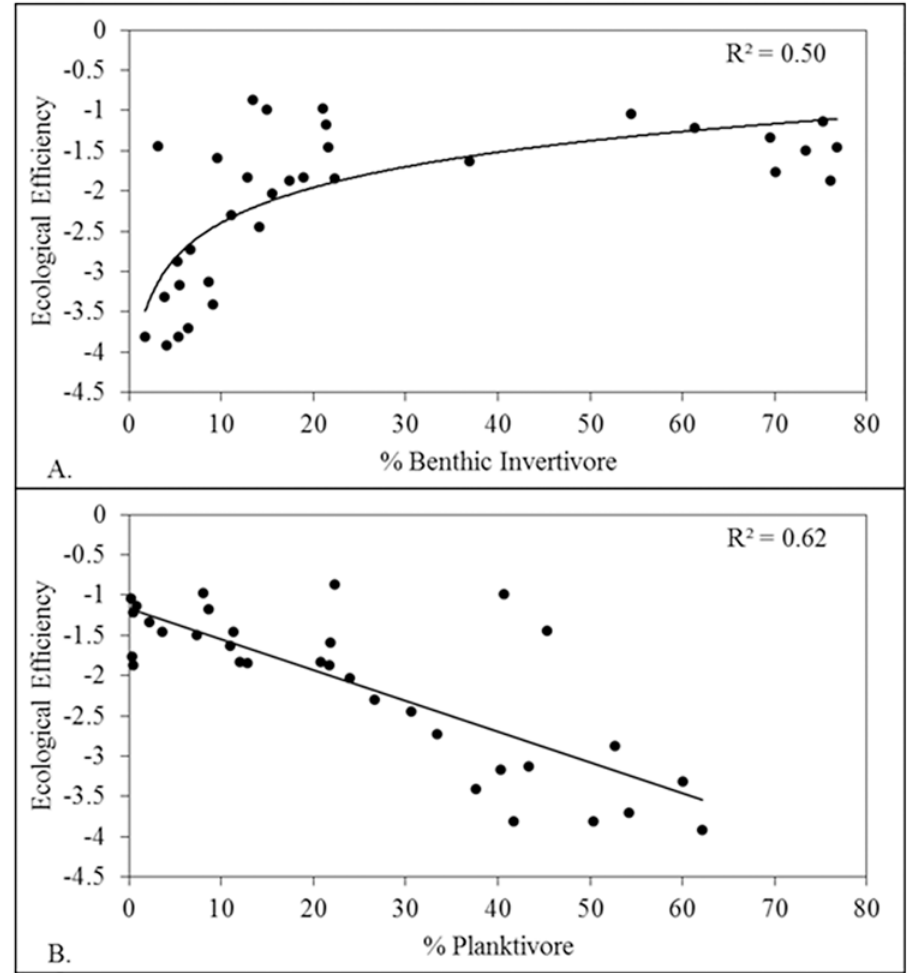
Fig 5. Temporal relationships of ecological efficiency with percent relative abundance for two functional feeding groups: (A) benthic invertivores, (B) planktivores.